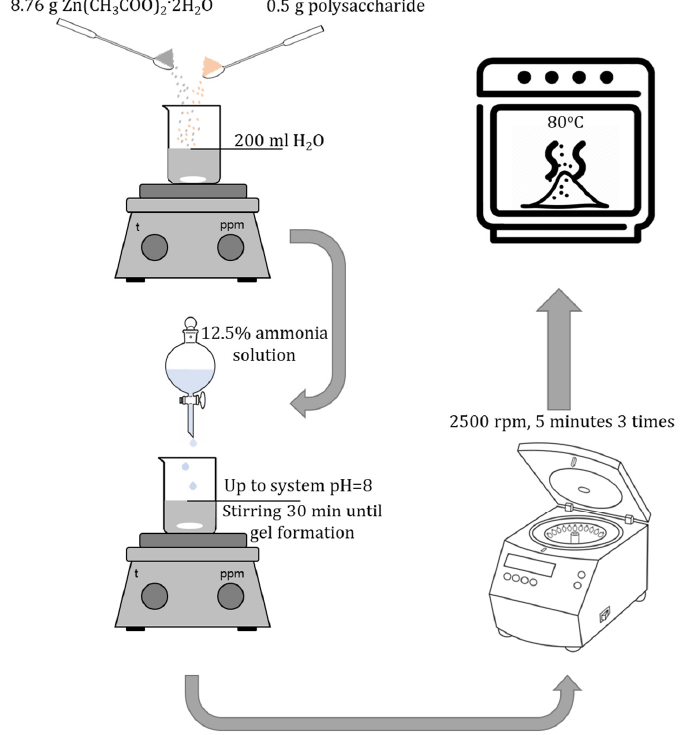
Figure 18. Scheme of synthesis of gels of ZnO NPs modified with polysaccharides.